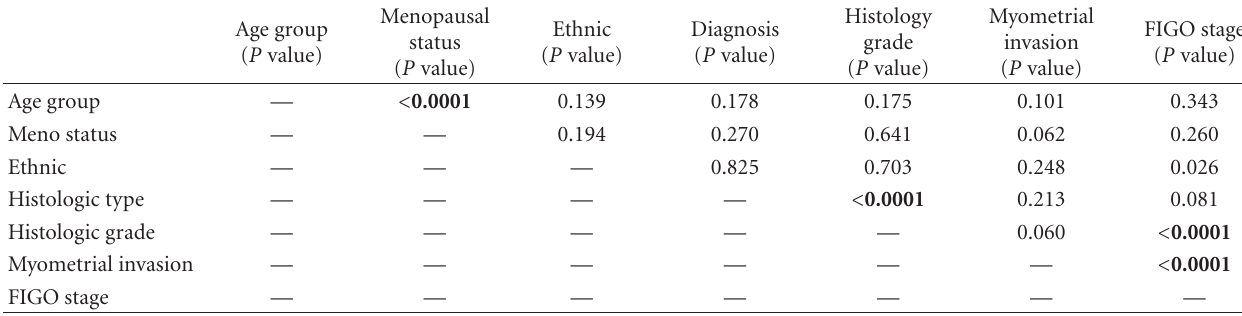
— — — — — — ∗ Calculated using